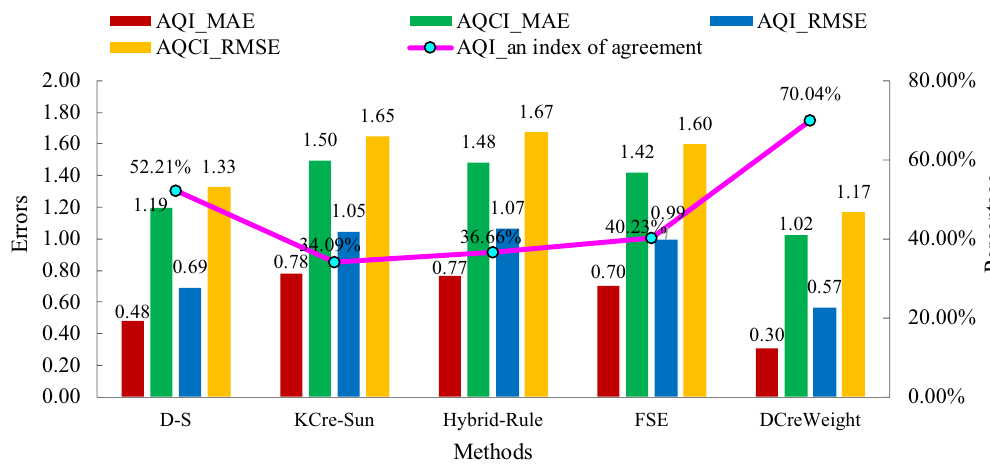
Figure 5. Performance comparison results of the evaluation methods.